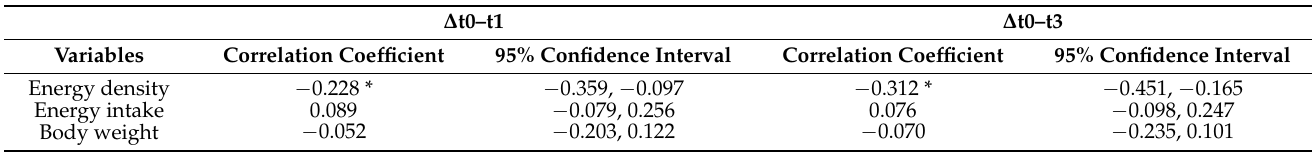
Table 5. Association between changes in HEI-NVS and changes in dietary, anthropometric, and cardiometabolic variables (ITT analysis) 1